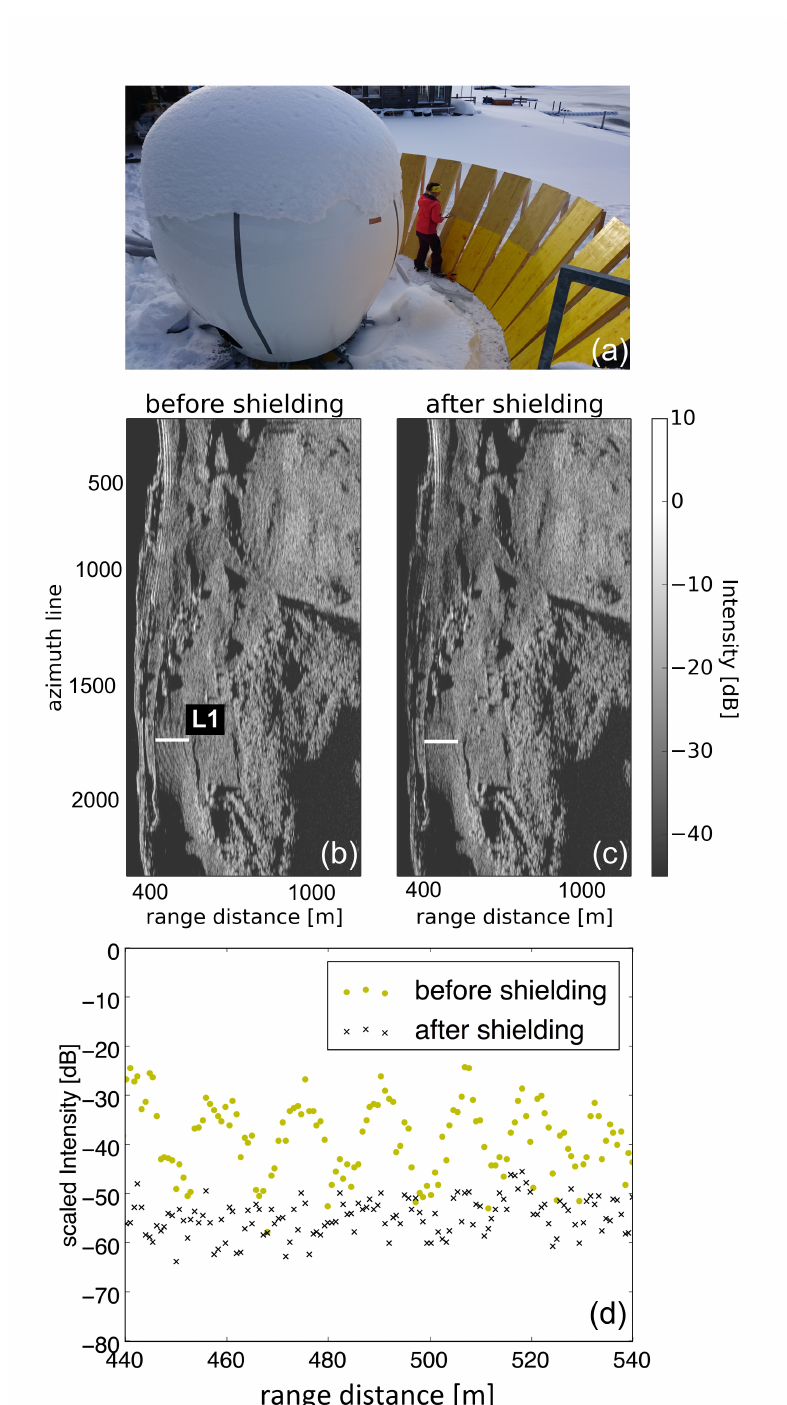
Figure 12. ( a ) photo of the shielding setup. The wooden scaffolding is covered with a fine-meshed (6mm) aluminium grid; ( b ) backscatter intensity images before and ( c ) after shielding of the reflective surface. The MPI pattern is strongly reduced; ( d ) backscatter intensity along L1 averaged over 10 neighbouring azimuth lines before and after shielding; ( a – d ) illustrate the geometrical requirements for the occurrence of multipath